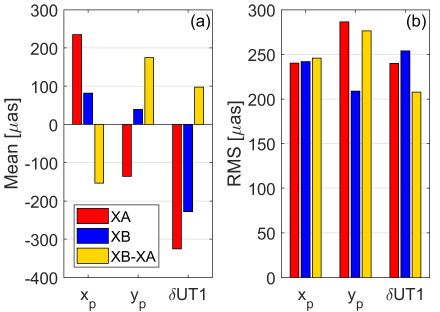
Figure 5. RMS of ERP estimates w.r.t. a priori values and differ- ences from VLBI sparse networks and VLBI + RL, including per- centage of RMS reduction due to ring laser